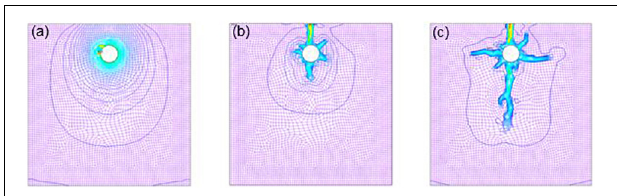
FIGURE 3 | 3D FEM image, showing the reinforced concrete corrosion-induced cracking stages, (a) pit initiation, (b) crack initiation, and (c) crack propagation process.